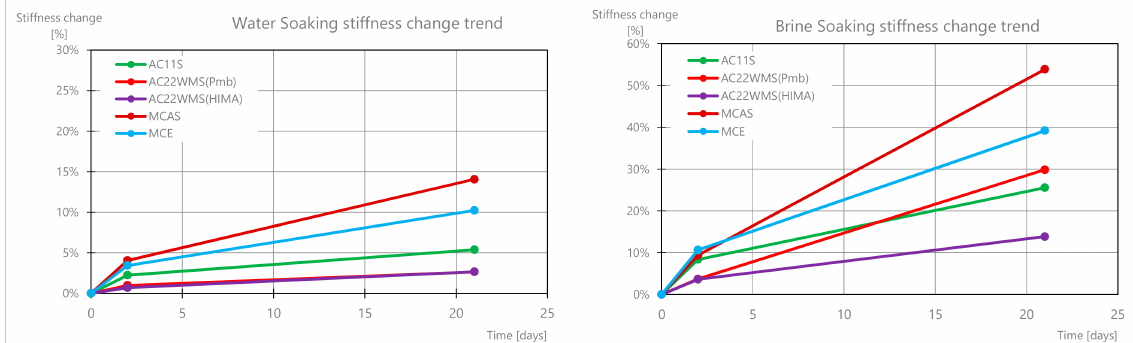
Figure 18. Results of the percentage changes in the stiffness modulus for different mixes over